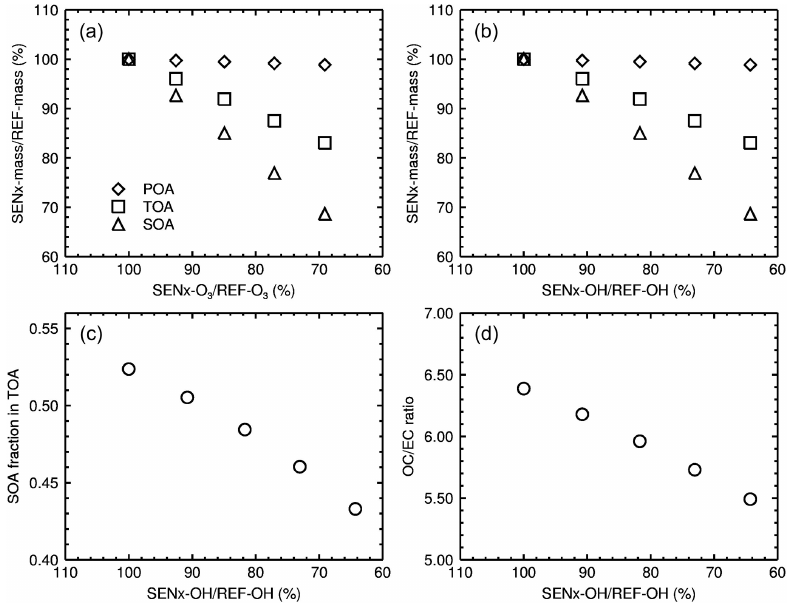
Figure 10. Impacts of changes in the AOC on organic aerosol components in BTH in four sensitivity experiments. (a) Concentration changes of POA, SOA, and TOA versus O 3 . (b) Concentration changes of POA, SOA, and TOA versus OH. (c) SOA fraction in TOA versus OH concentration change. (d) OC / EC ratio versus OH concentration change.